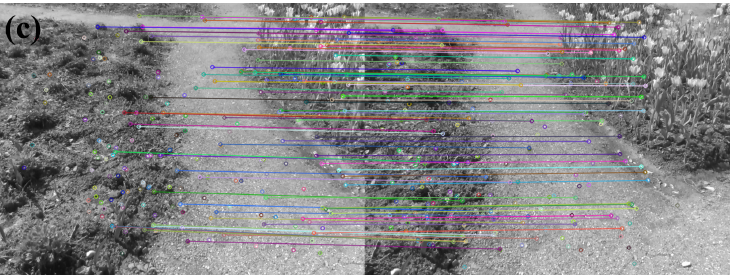
Figure 17. Results of feature matching using the proposed algorithm under three other scenes: ( a ) weak light scene; ( b ) high texture scene; and ( c ) low texture